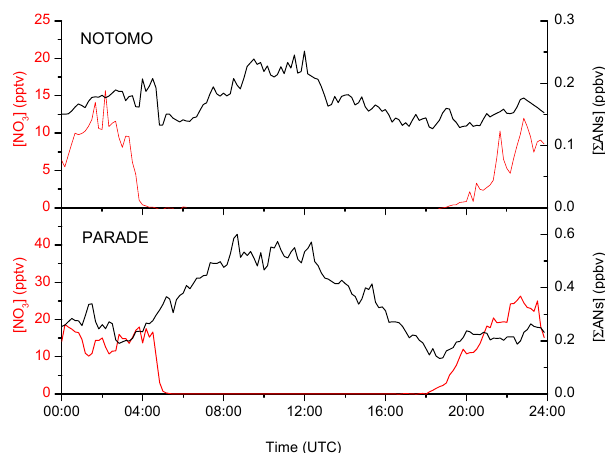
Figure 6. Mean daily profiles of NO 3 (red) and (cid:54) ANs (black) for the NOTOMO (top) and PARADE campaigns (bottom) for relative humidity <